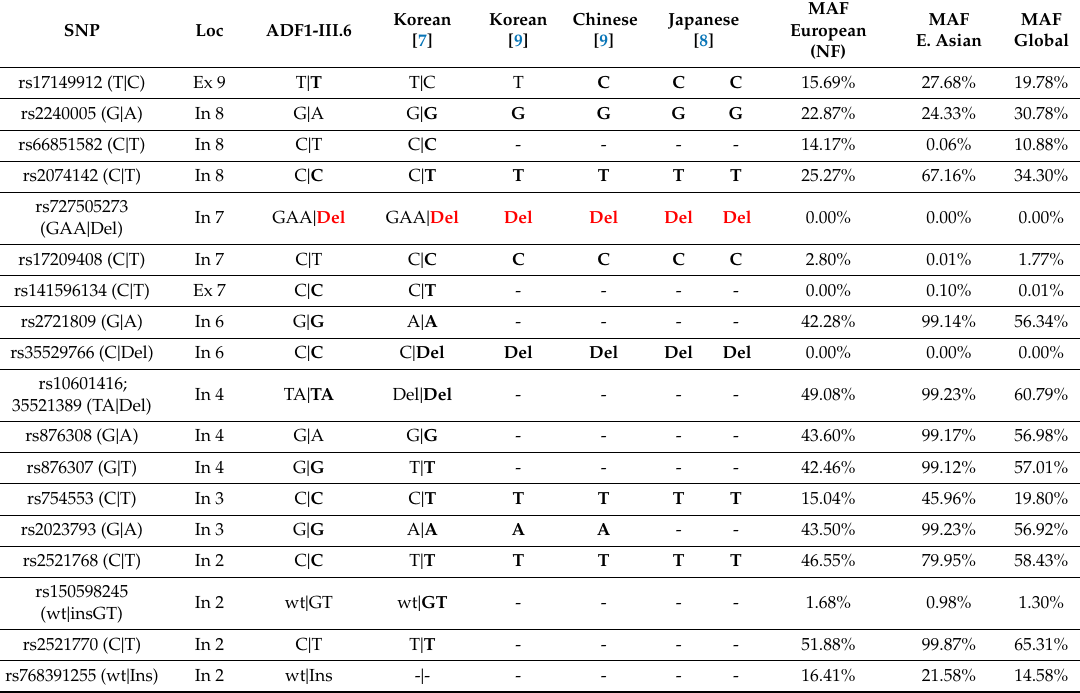
Table 2. Haplotype analysis for DFNA5 for the c.991-15_991-13delTTC mutation between East Asians and